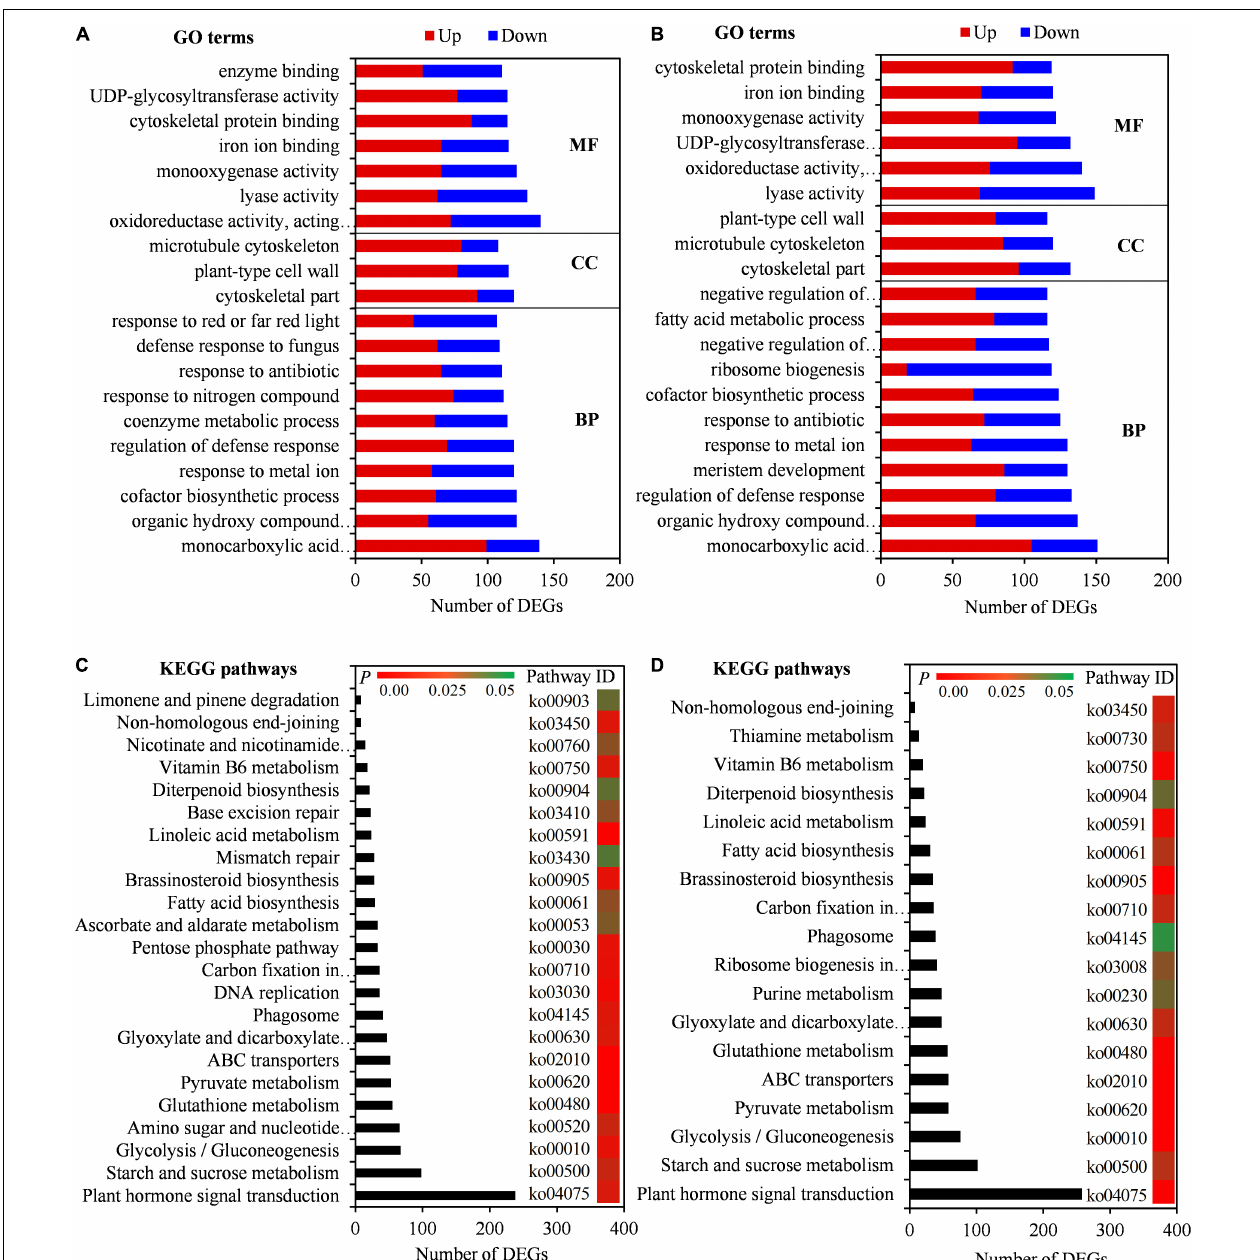
FIGURE 3 | DEGs enriched on Gene Ontology (GO) terms and Kyoto Encyclopedia of Genes and Genomes (KEGG) pathways under NaCl (SC) and BW stresses. Top 20 GO terms of DEGs in (A) SC vs. control (CK) and (B) BW vs. CK. BP, CC, and MF represent biological process, cellular component, and molecular function, respectively. Significantly enriched KEGG pathways of DEGs in (C) SC vs. CK and (D) BW vs.